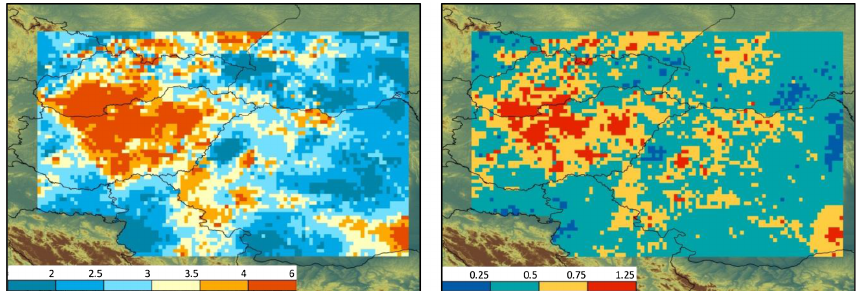
Figure 3. Average number of months per year with moderate drought (Sc-PDSI ≤ − 2 . 0; left) and extreme drought (Sc-PDSI ≤ − 4 . 0; right) in the Carpathian region